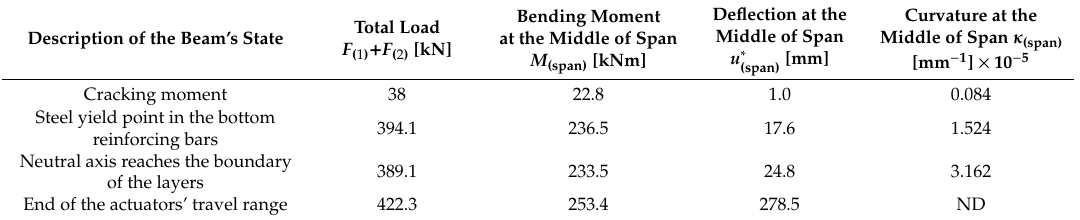
Table 5. Total load, bending moment, deflection and curvature for the selected states of beam #1.